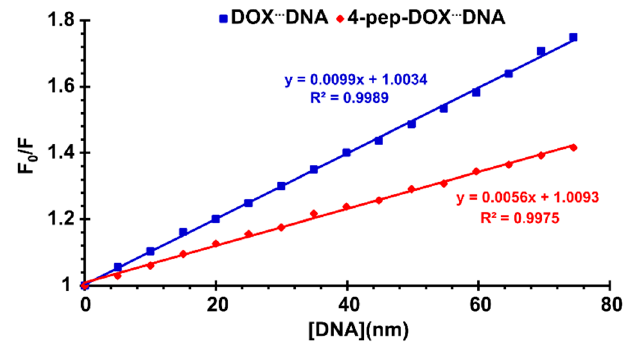
Figure 6. Stern–Volmer plots for the DOX ... dsDNA and 4-pep–DOX ... dsDNA systems in 10 mM Tris-HCl buffer (pH 7.2) at 25 °C.